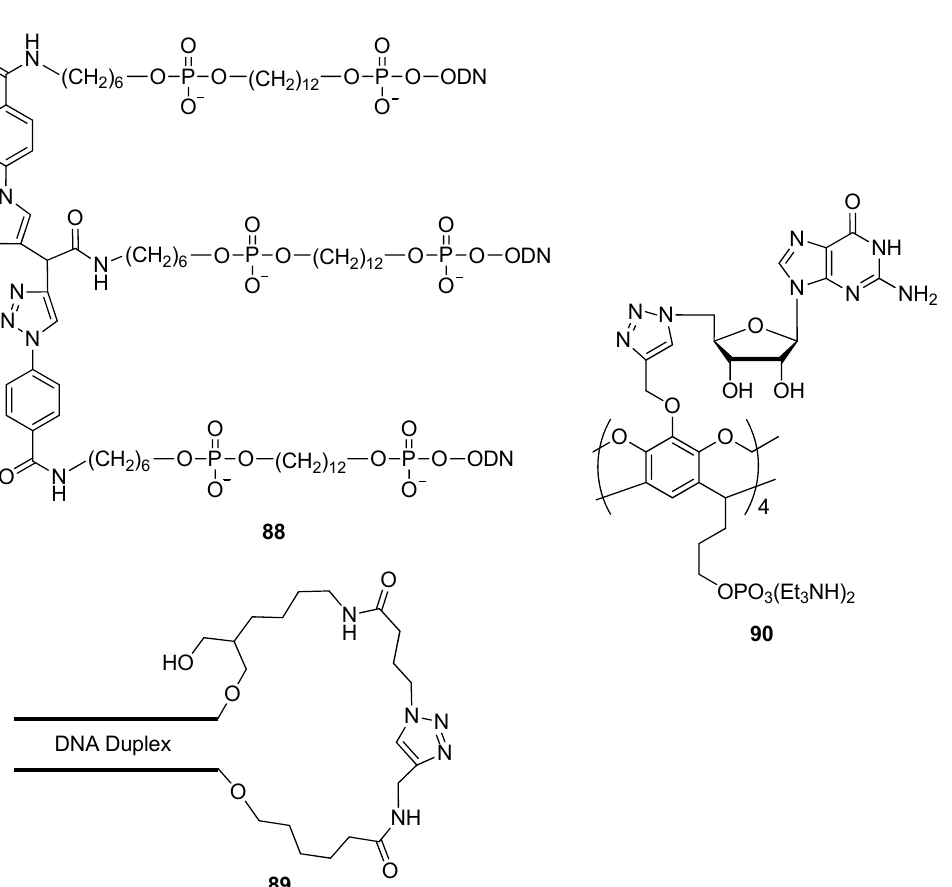
Figure 15. Representatives of other click-conjugated